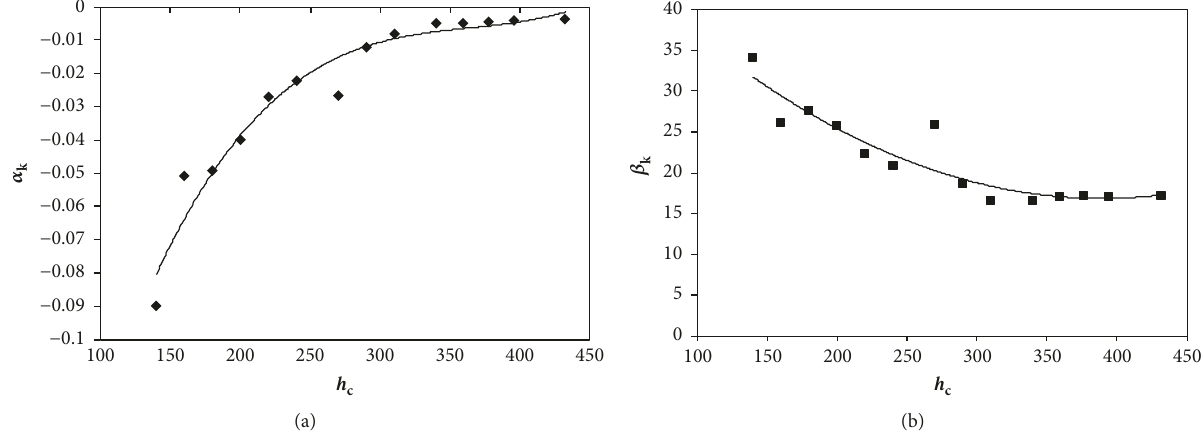
Figure 8: 𝛼 k , (a) and the intercept 𝛽 k (b) of equation